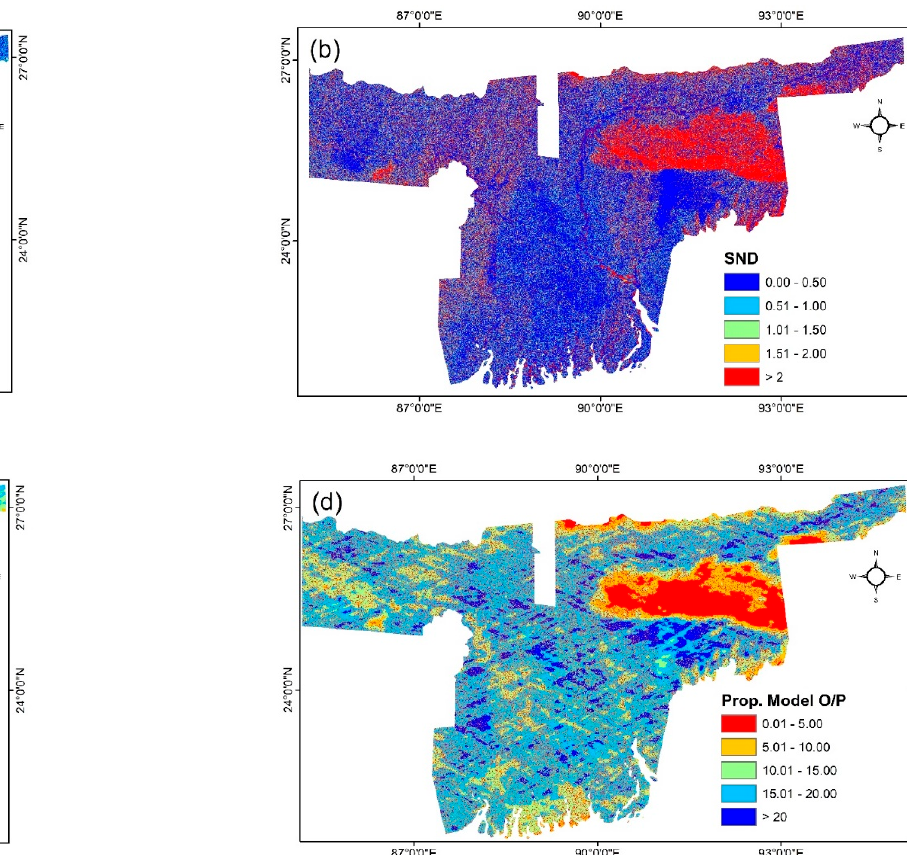
Figure 4. Case II ( a ) HAND flood terrain model for North India; ( b ) SND obtained for North India; ( c ) maximum SNR obtained from CYGNSS for August 2017; ( d ) model output for North India during floods of August 2017.